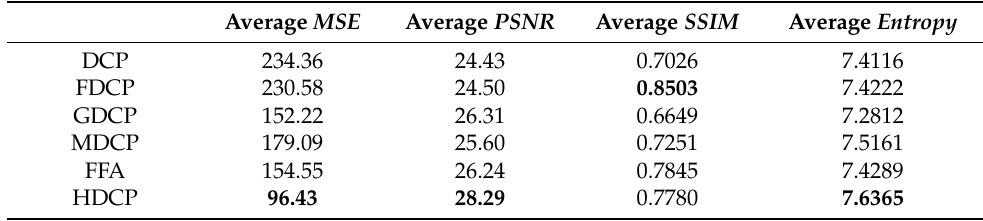
Table 6. Comparison of the overall objective evaluation results of different algorithms on the en- hancement of the NYU2